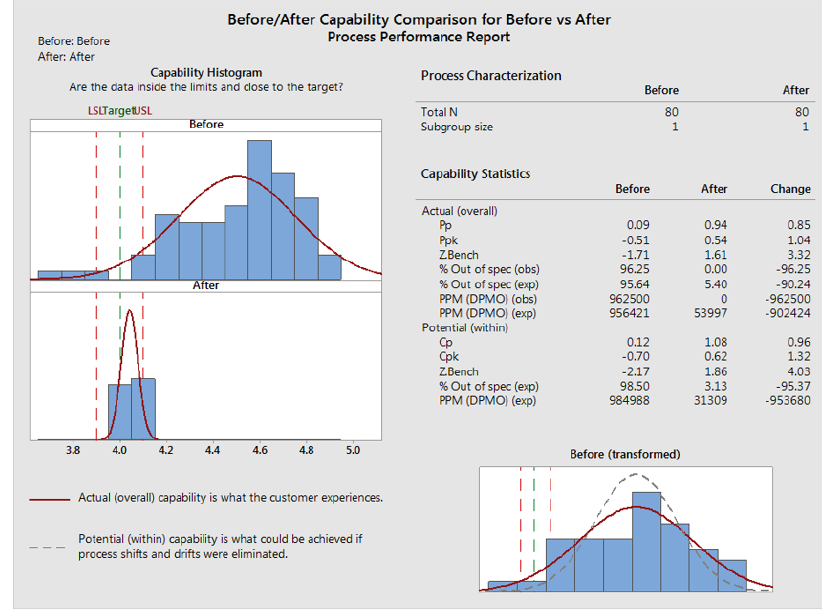
Figure 21. Before/after capability comparison.